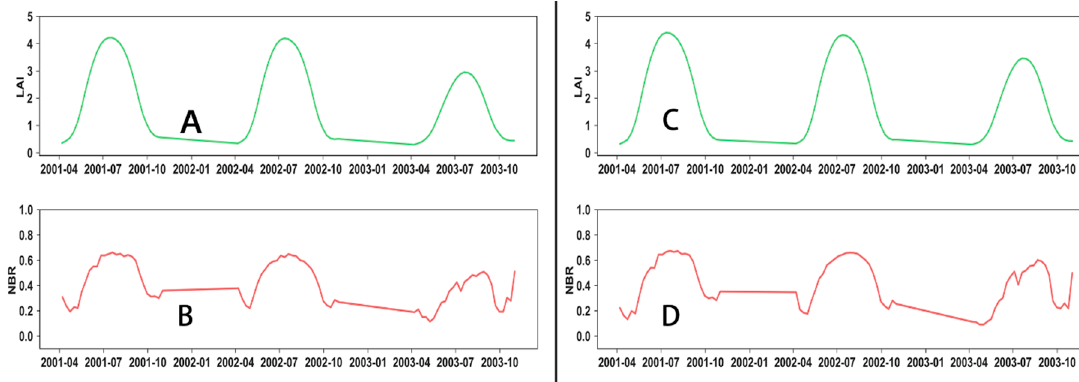
Figure 6. The LAI (green) and NBR (red) time series in the study area. ( A , B ) are detected as burned pixels in the TSM algorithm, and ( C , D ) are detected as unburned.